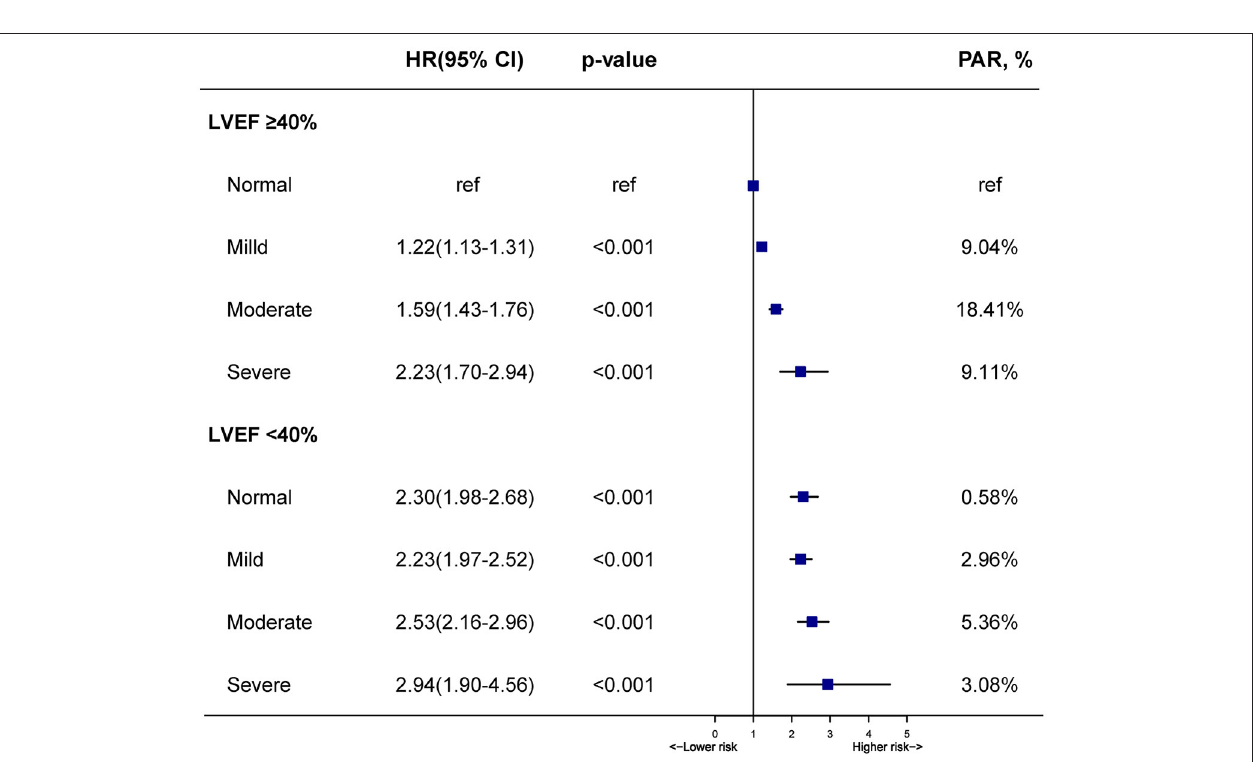
FIGURE 4 | Hazard ratios and population-attributable risk for all-cause mortality across malnutrition and LVEF categories. Model adjusted for age, gender, percutaneous coronary intervention, hypertension, diabetes mellitusc, anemia, stroke, coronary artery disease, chronic kidney diseases, atrial fibrillation, low-density lipoprotein cholesterol, high-density lipoprotein cholesterol, triglycerides and statins.